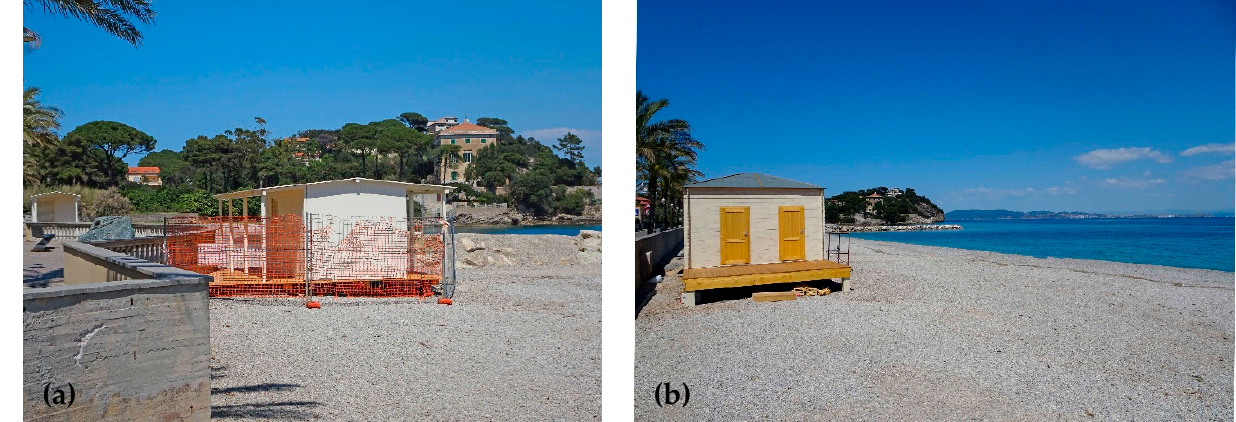
Figure 14. A small bar (a) and toilets (b) on the new gravel beach (April, 2017).